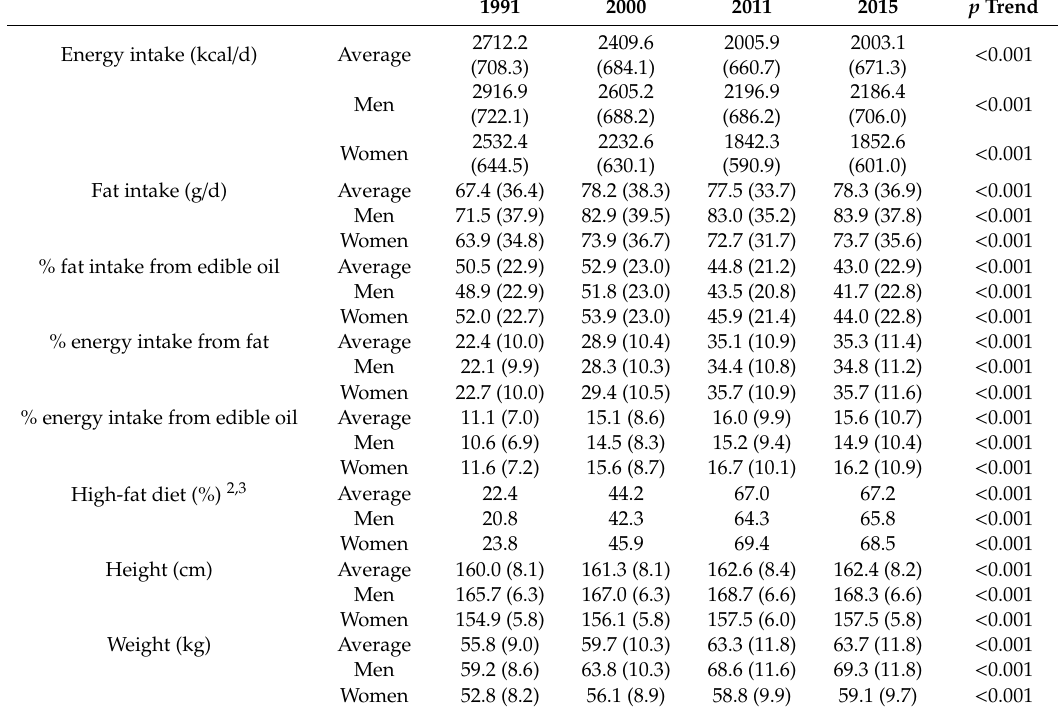
Table 2. Fat intake and prevalence of overweight and obesity, China Health and Nutrition Survey, 1991–2015 1